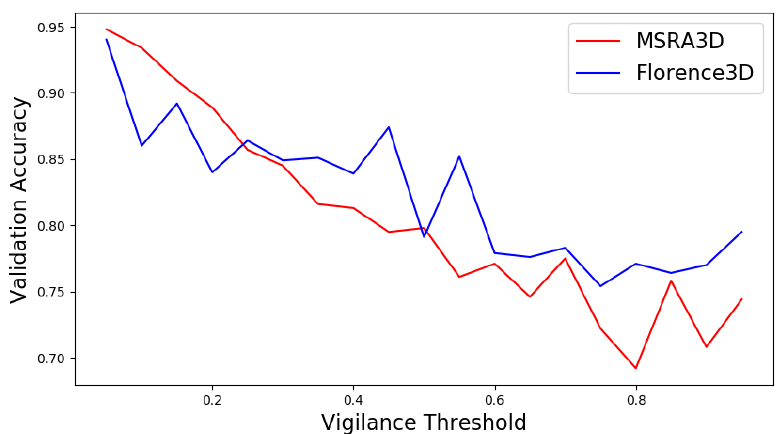
Figure 7. The graphs depict the impact of tuning the vigilance threshold from 0.05 to 0.95 on the performance of SO-ConvESN in HAR task based on MSRA3D dataset (Red Solid line) and Flo- rence3D dataset (Blue Solid line). In both models, when the vigilance threshold increases, validation accuracy